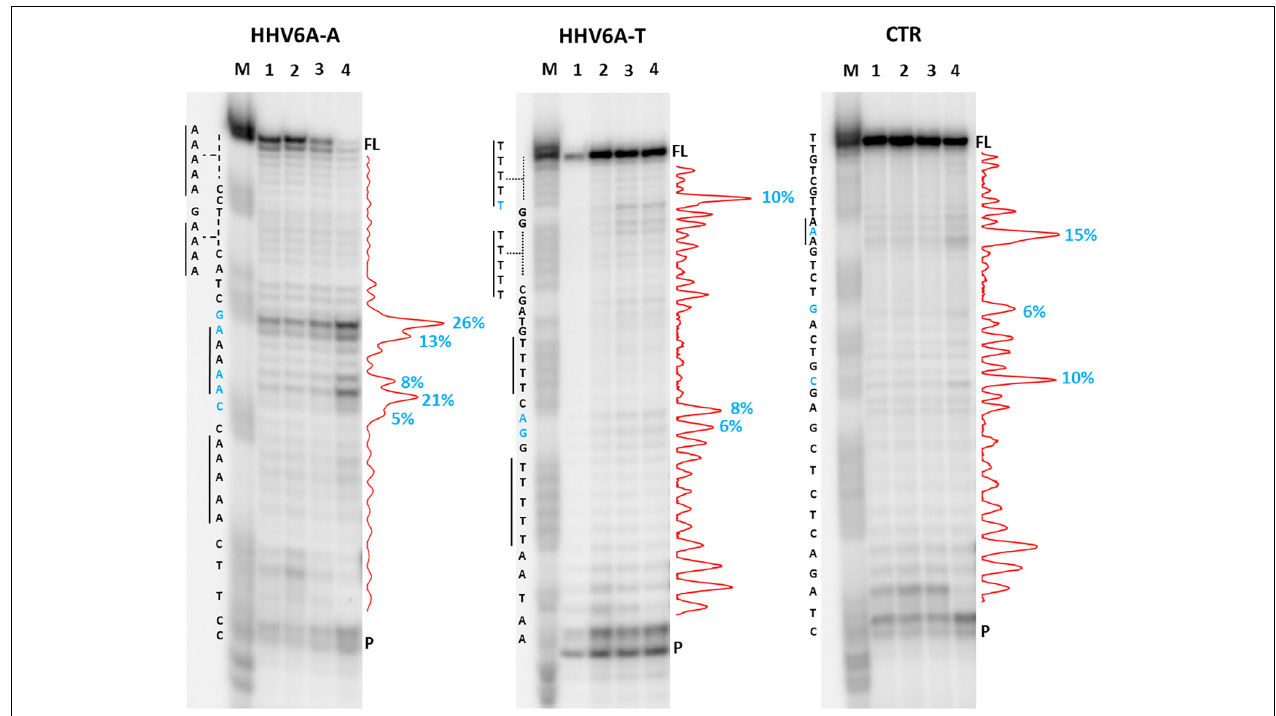
FIGURE 7 | Taq polymerase stop assay on HHV6A sequences. Analysis was performed in the presence of 100 mM of different salt types, such as KCl (1), NaCl (2), LiCl (3), and NaF (4). M indicates a sequence marker lane, obtained by the Maxam and Gilbert sequencing protocol; P indicates the unreacted labeled primer; FL indicates the full-length elongation product. Red densitograms show stop bands quantification. Percentages of peaks ( ≥ 5%) are reported in blue, along with the corresponding nucleotide. Elongation was performed at 37 ◦